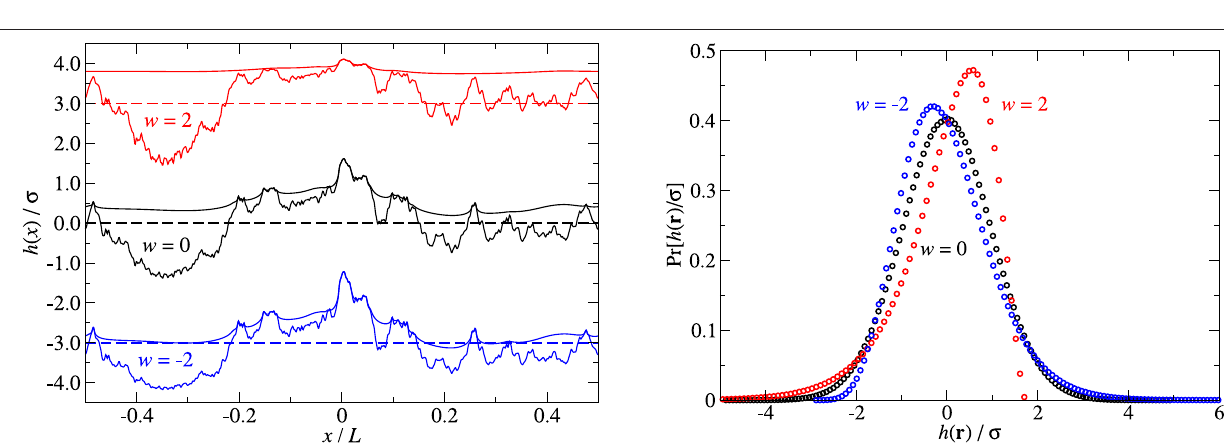
FIGURE 2 | (Left) Contacts between an elastic body and indenters with different warpings w (top to bottom w contact area. The dashed lines indicate the indenters’ center-of-mass height for the shown cross section. The curves w their visualization. (Right) Height histograms for the different surfaces. The number of grid points for each warped surface is fixed to 4,096